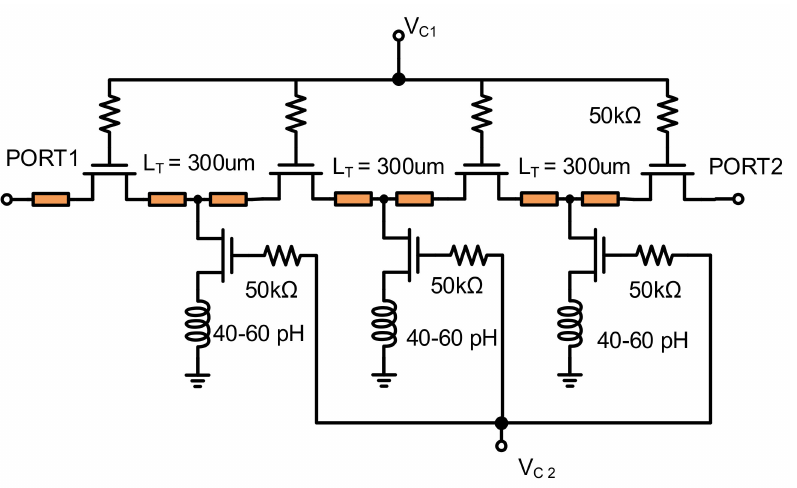
Figure 7. The details of the signal path from input to output when activating one